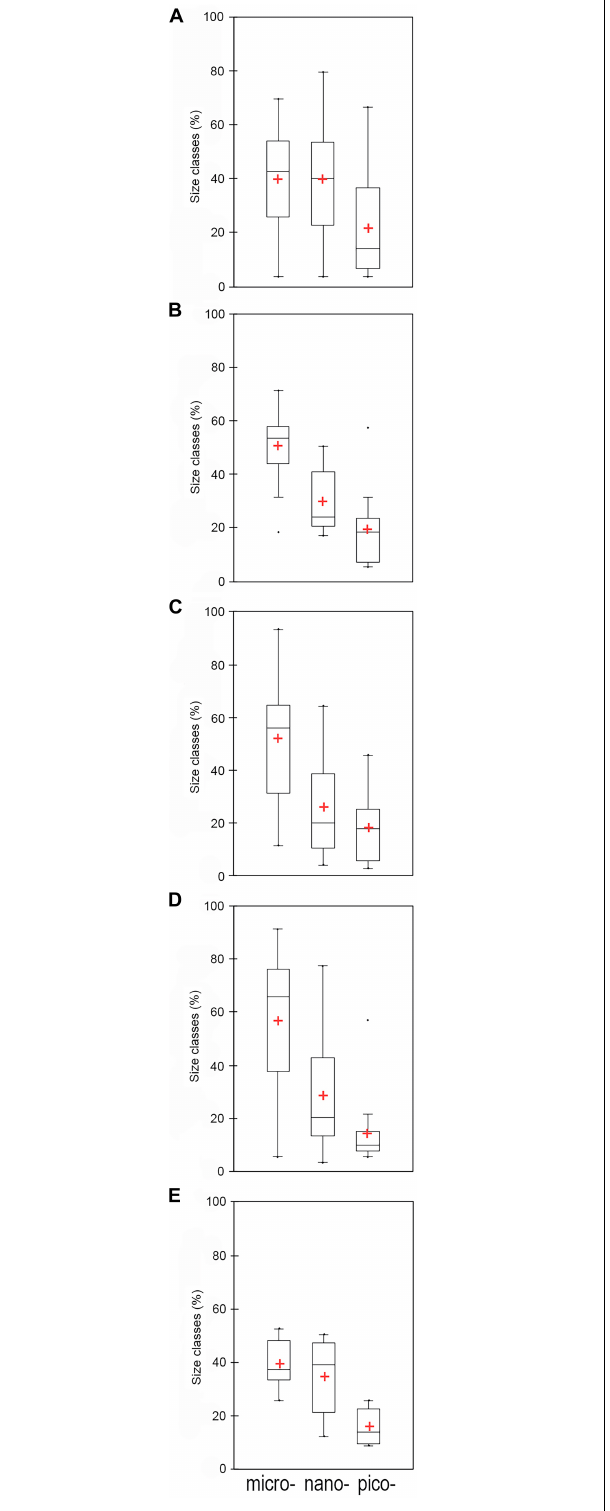
FIGURE 7 | Percentage contribution of size classes, i.e., micro- ( > 20 µ m), nano- (20–2 µ m), pico- ( < 2 µ m), in Area 1 (A) , 2 (B) , 3a (C) , 3b (D) , and 4 (E) . The black line is the median and the red cross is the mean.